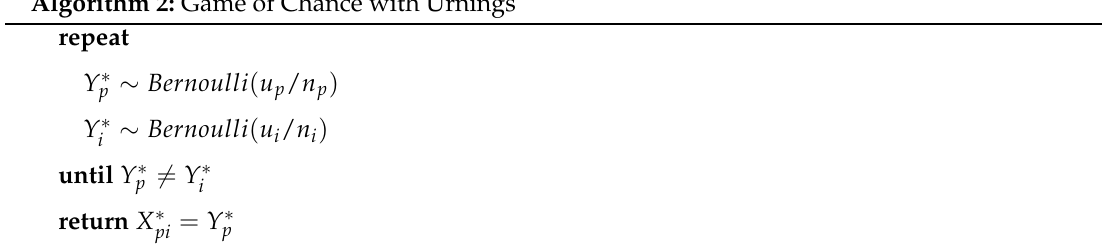
Algorithm 2: Game of Chance with